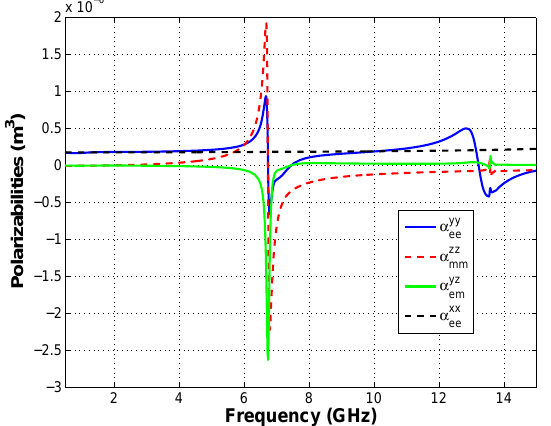
Figure 7: Real part of the polarizabilities of the EC-SRR, extracted via the proposed method.